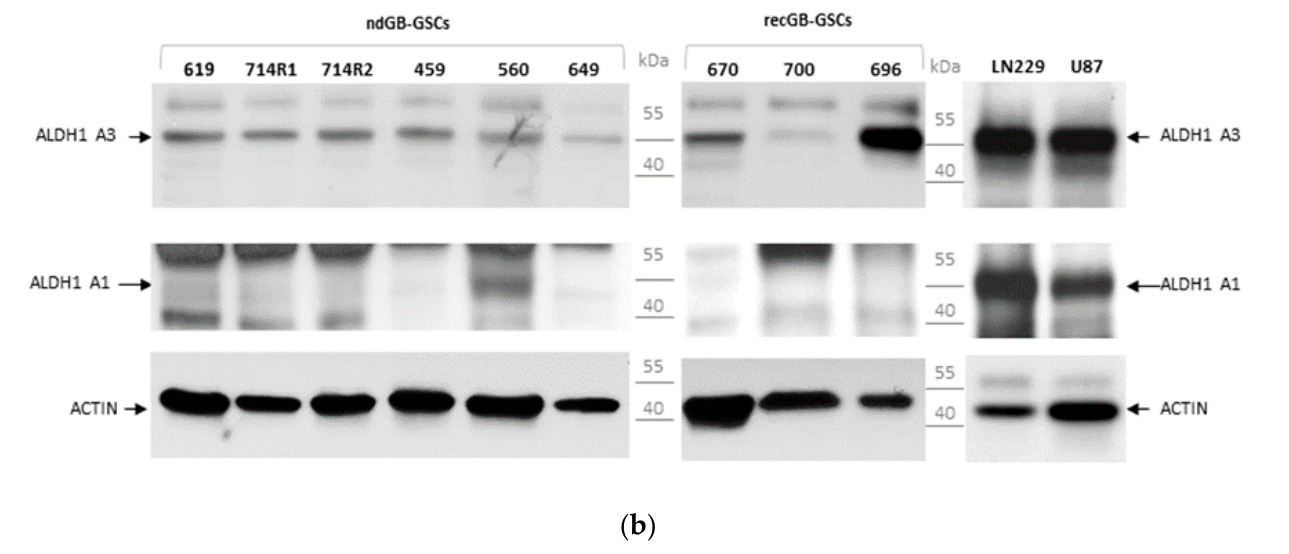
Figure 2. Western blot analyses of total protein content in patient-derived GSCs and non-stem glioma cells U87 and LN229. ( a ) Comparative assessments for GSC markers CD133 and PDGFR α . Patient-derived GSCs express CD133 and PDGFR α show the expression of either CD133 or PDGFR α , or both, whereas non-stem glioma cells U87 and LN229 are devoid of either CD133 or PDGFR α . ( b ) Comparative assessments of ALDH1A1 and ALDH1A3 in patient-derived GSCs and non-stem glioma cells U87 and LN229. Non-stem glioma cells express both ALDH1A1 and ALDH1A3 isoforms, whereas patient-derived GSCs show preferential expression of ALDH1A3.